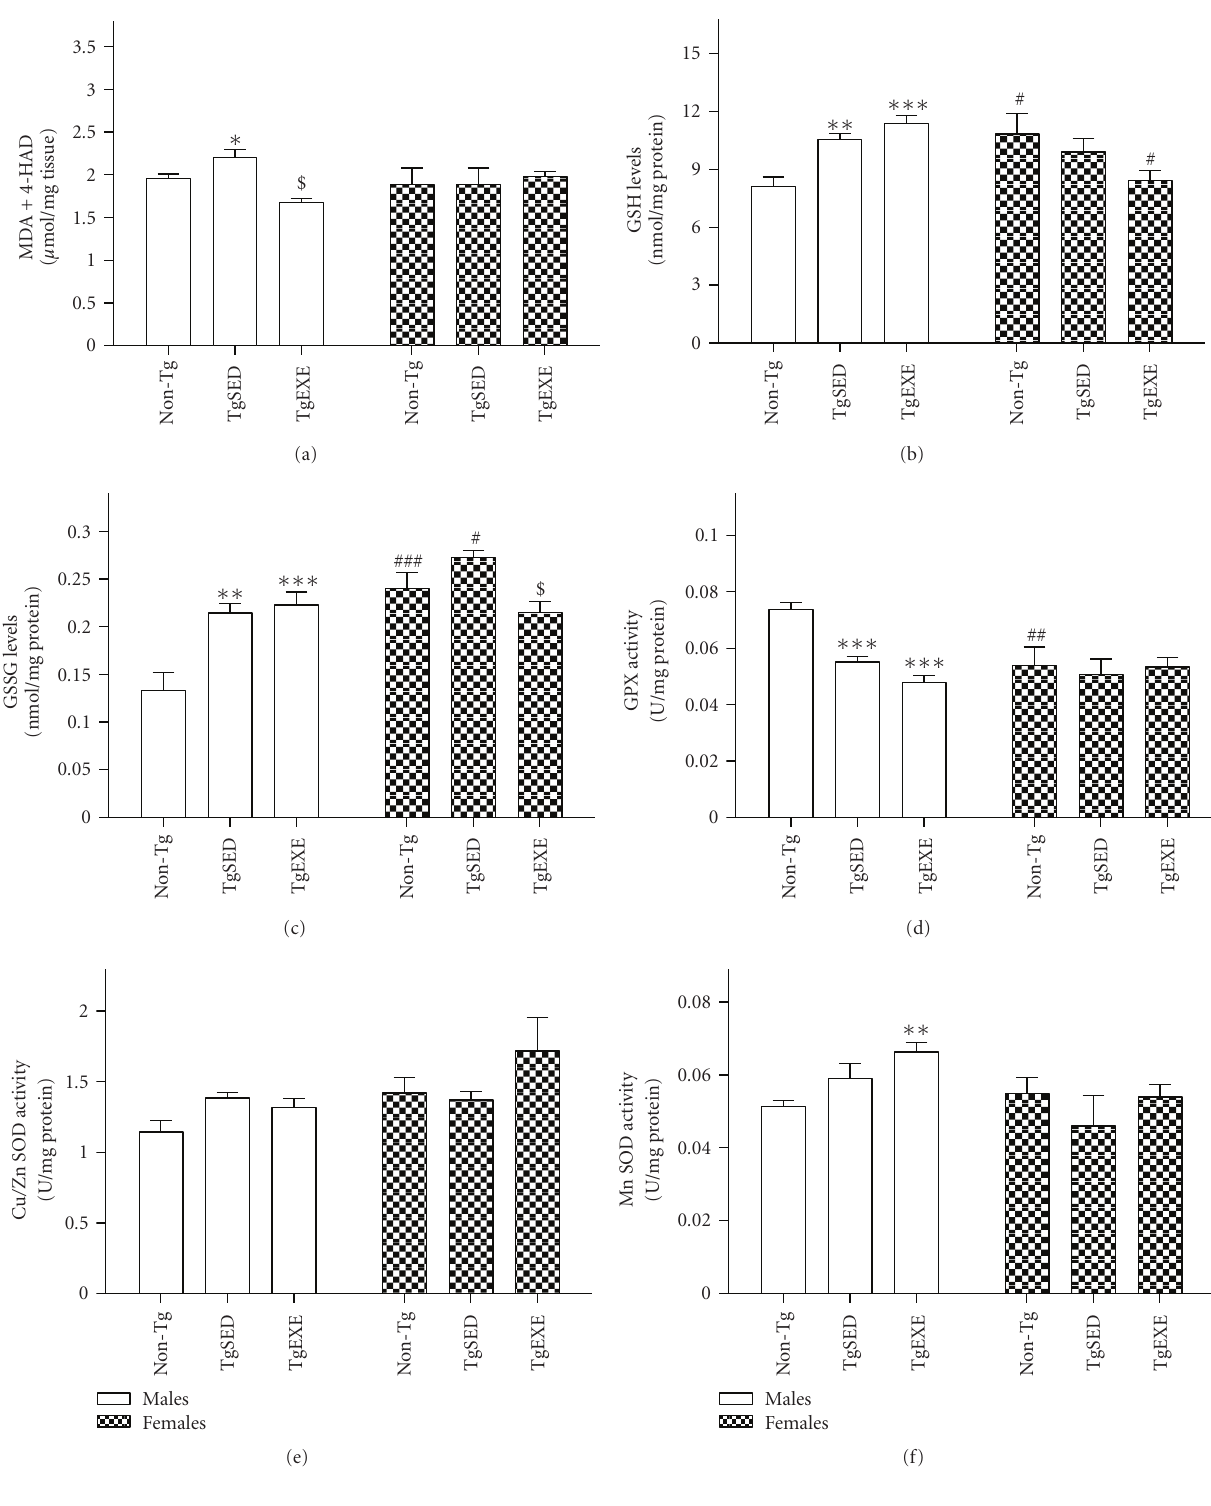
Figure 4: Oxidative stress in the cerebral cortex of sedentary male 3xTg-AD mice (TgSED) is partially ameliorated by treadmill running exercise (TgEXE), whereas 3xTg-AD females show less alteration. Tissue of sedentary nontransgenic mice (non-Tg) was analyzed as a reference. (a) Lipid peroxidation levels expressed as malondialdehyde (MDA) plus 4-hydroxyalkenal (4-HAD). (b) Levels of reduced glutathione (GSH). (c) Levels of oxidized glutathione (GSSG). (d) Glutathione peroxidase (GPx) enzymatic activity. (e) SOD-CuZn enzymatic activity. (f) SOD-Mn activity. Data represent the mean ± SEM of 4–8 animals, tested in duplicate. Statistics: ∗ P < . 05, ∗∗ P < . 01, and ∗∗∗ P < . 001 compared to non-Tg; # P < . 05 compared to